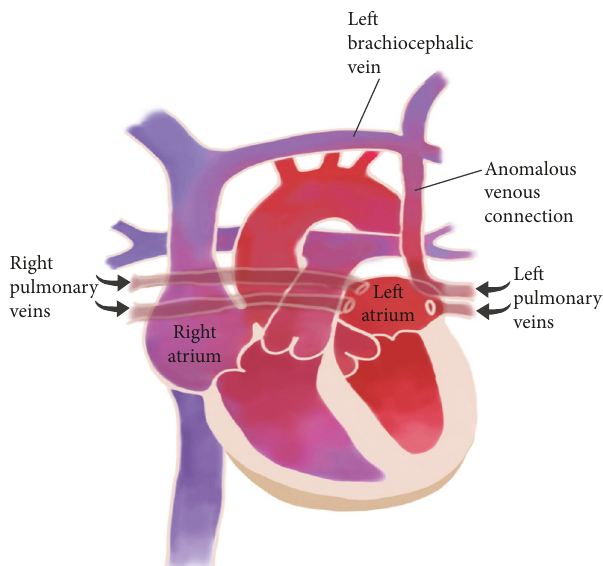
Figure 3: Schematic illustration of the anatomy of the CVL inserted accidentally in an anomalous pulmonary vein connected to the right atrium via the brachiocephalic